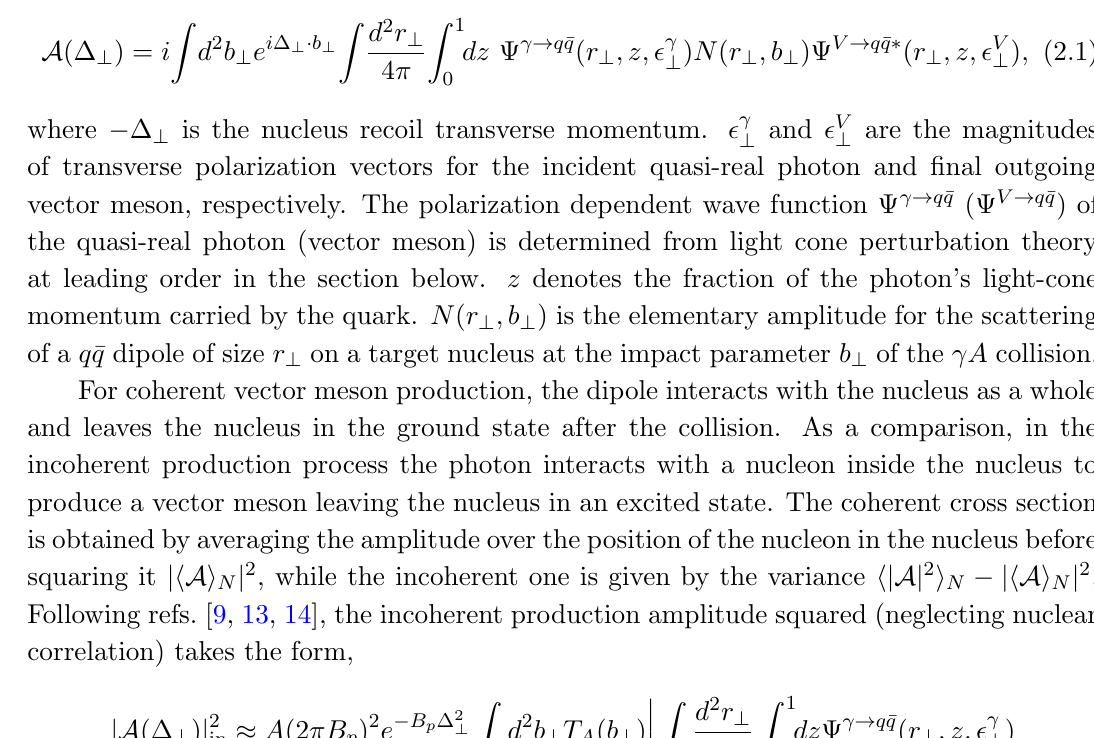
Figure 1 . Diagram for di(cid:11)ractive (cid:26) 0 meson production in ultraperipheral heavy ion collisions. as the convolution of the dipole scattering amplitude and the overlap between the vector meson and photon wave functions in position